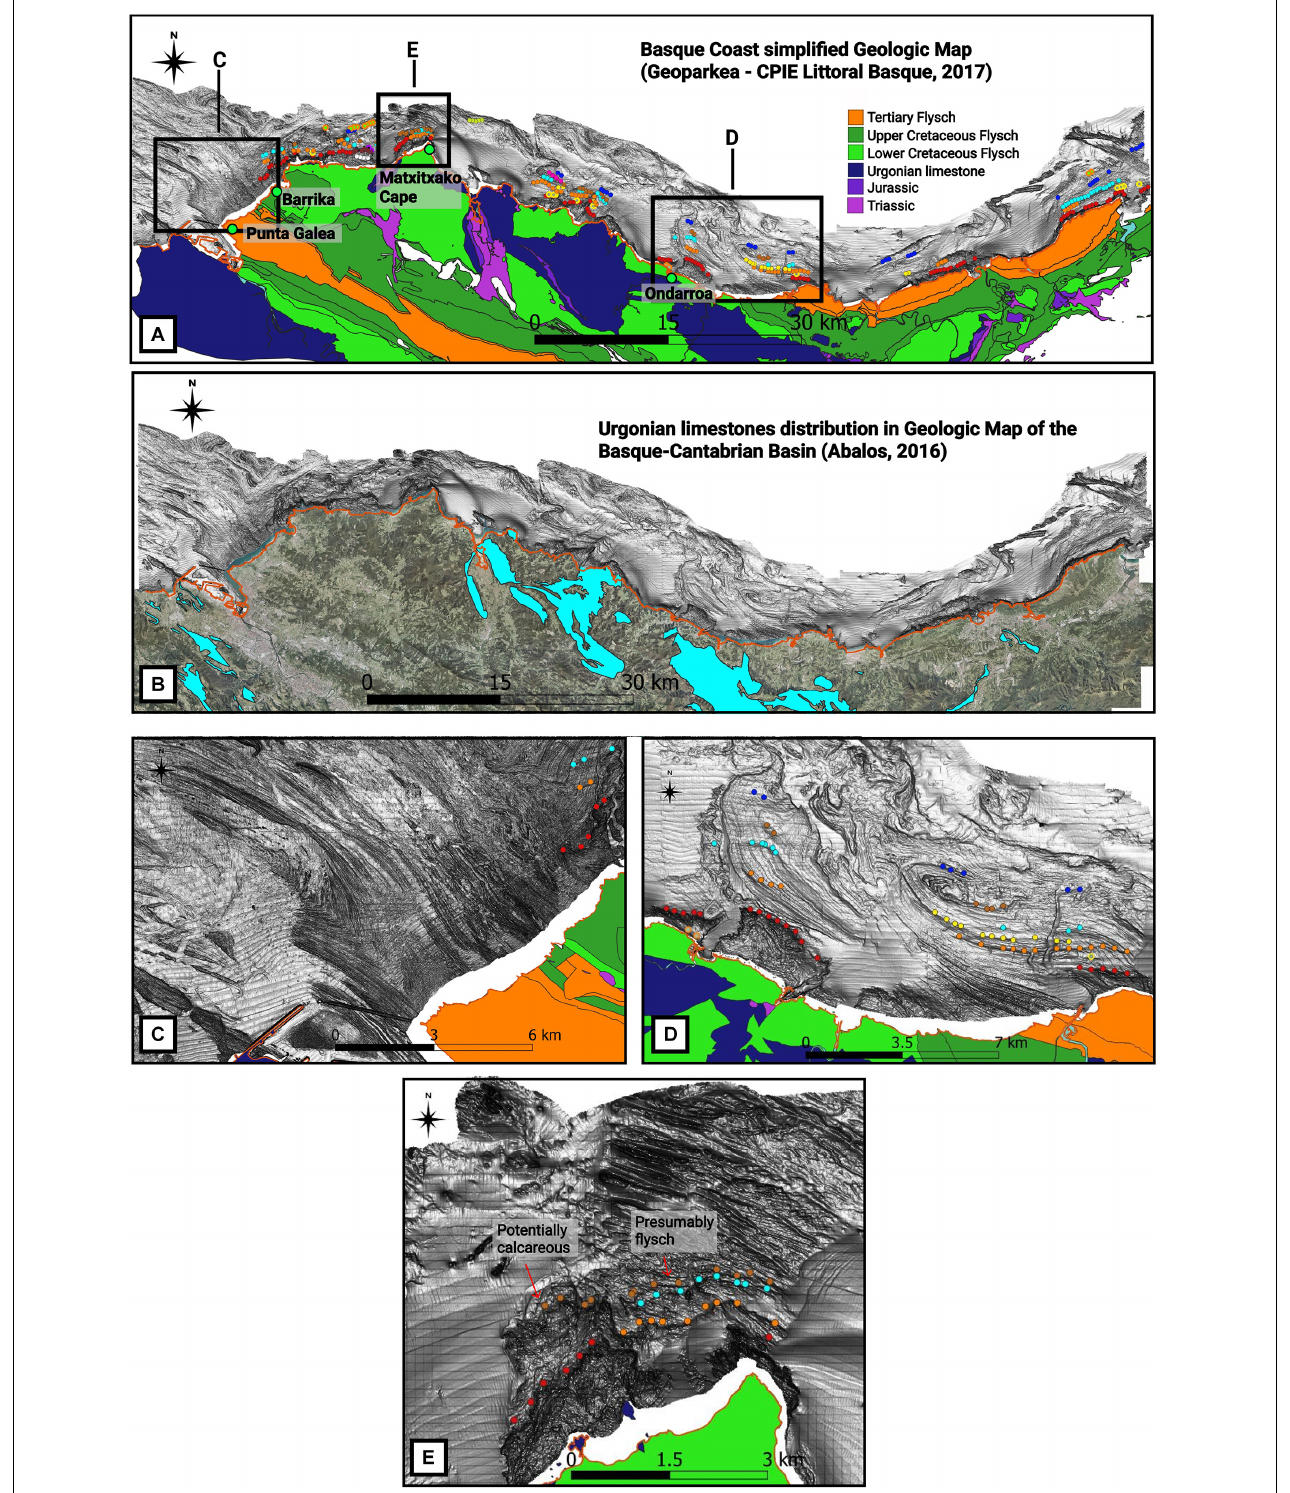
FIGURE 11 | Relationship between the submerged terraces and lithology. (A) Lithologic map modified from the Basque Coast (Euskal Kostaldeko Geologia Sinplifikatua, 2017). (B) Urgonian limestone distribution in Ábalos (2016). Note the limestone extension difference between (A , B) . (C,D) Areas with stratified flysch type successions. Marine terraces are mainly preserved in (D) area. (E) A high wave energy area, where submerged terraces are preserved. This could be due to the potentially calcareous rocks substratum in the eastern part, which are more resistant than flysch type rocks.